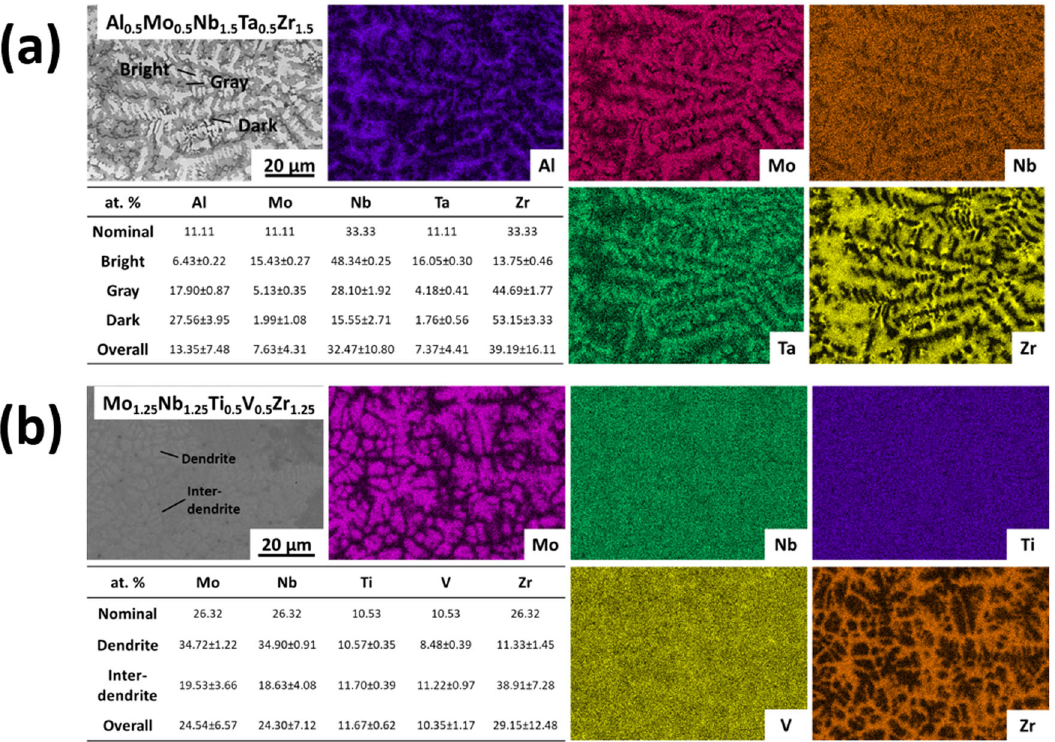
Fig. 6 EDX mapping and chemical compositions of the predicted compositions, Al 0.5 Mo 0.5 Nb 1.5 Ta 0.5 Zr 1.5 and Mo 1.25 Nb 1.25 Ti 0.5 V 0.5 Zr 1.25 . For panel ( a ), the brighter regions are rich in Mo, Nb, and Ta, while the darker regions are Al and Zr enriched. The other predicted composition,